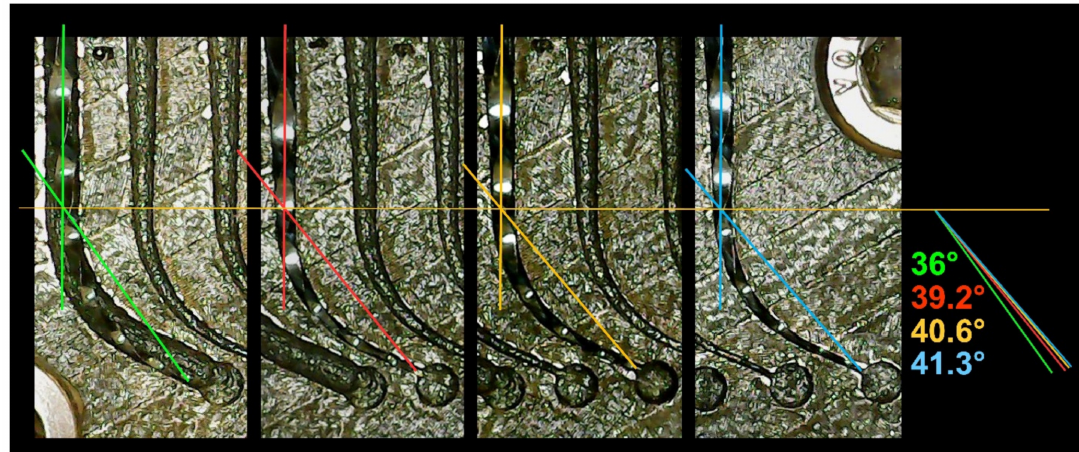
Figure 7. Straightening of the instrument due to increasing diameter of the artificial root canal. From left to right: parallel tube with a diameter of 1.25 mm (green), instrument size +0.10 mm (red), instrument size +0.05 mm (orange), matching tube = instrument size +0.02 mm